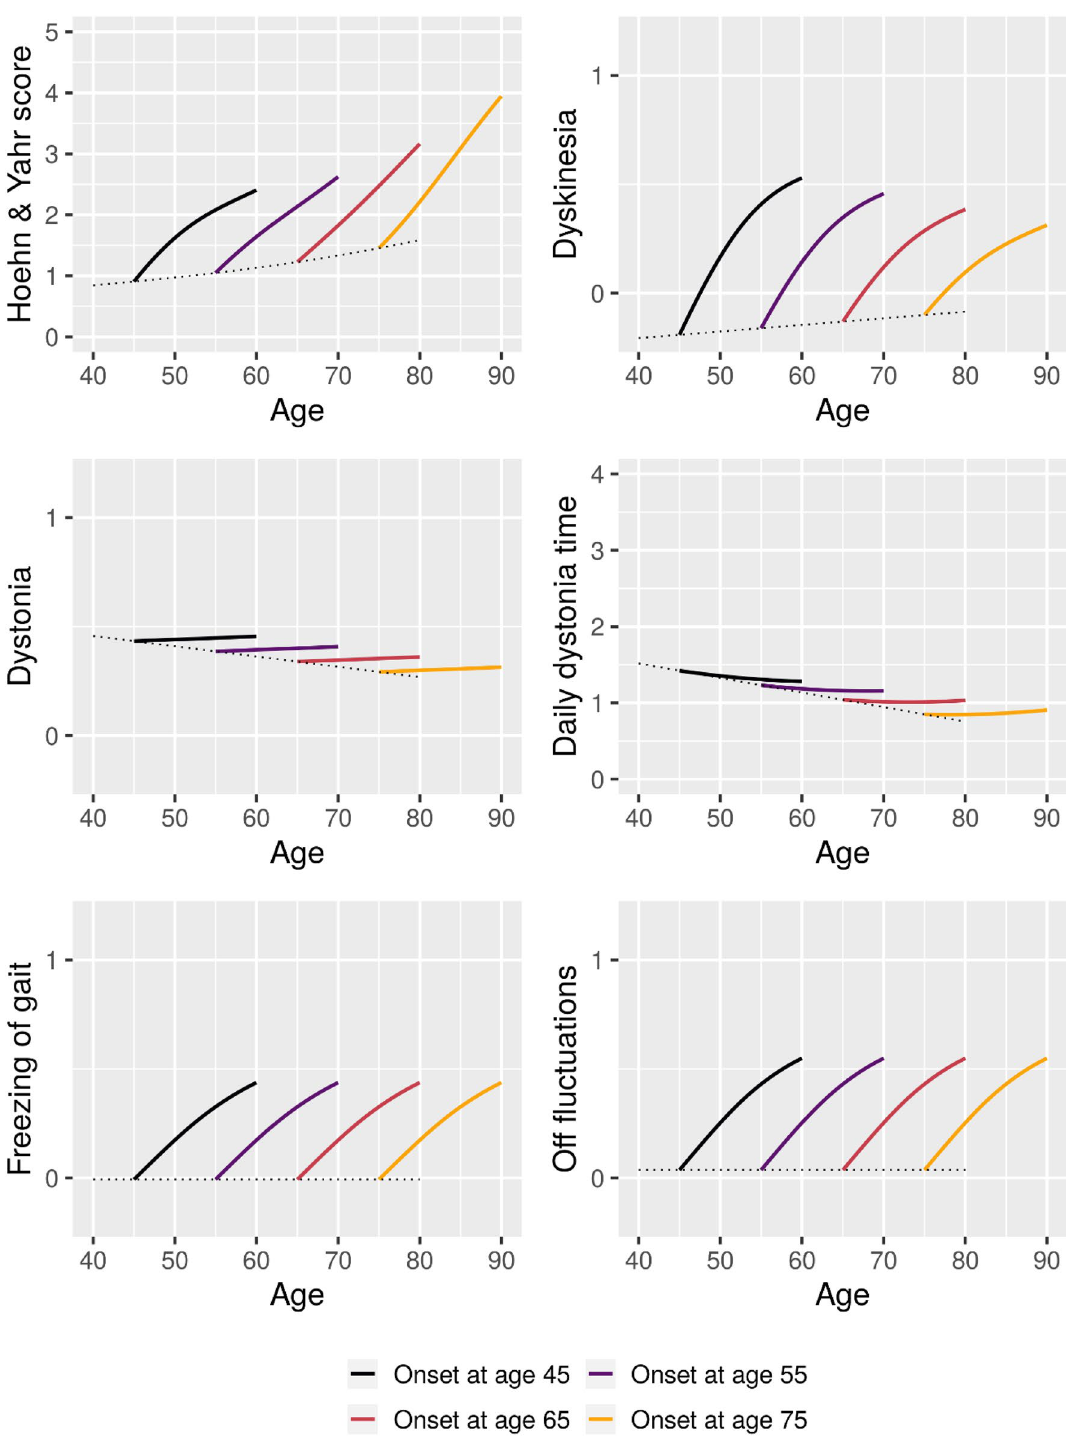
Figure 4. Estimated 15-year mean trajectories of staging and motor fluctuation outcomes from Parkinson’s disease onset at respectively 45, 55, 65, and 75 years of age. Trajectories estimated based on data from 2307 visits (Hoehn & Yahr) and 2510 visits (motor fluctuation outcomes). Dotted line represents the estimated mean scores for patients with onset at the given